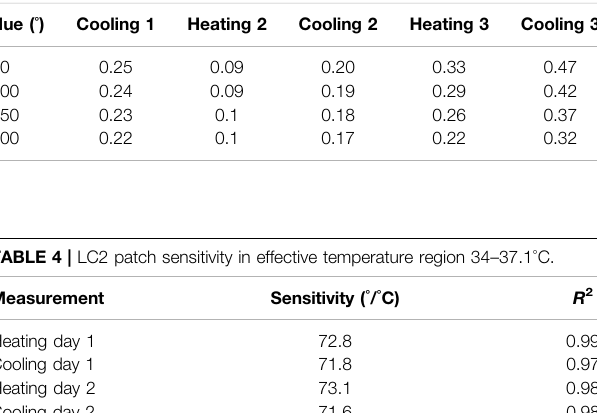
Frontiers in Bioengineering and Biotechnology |